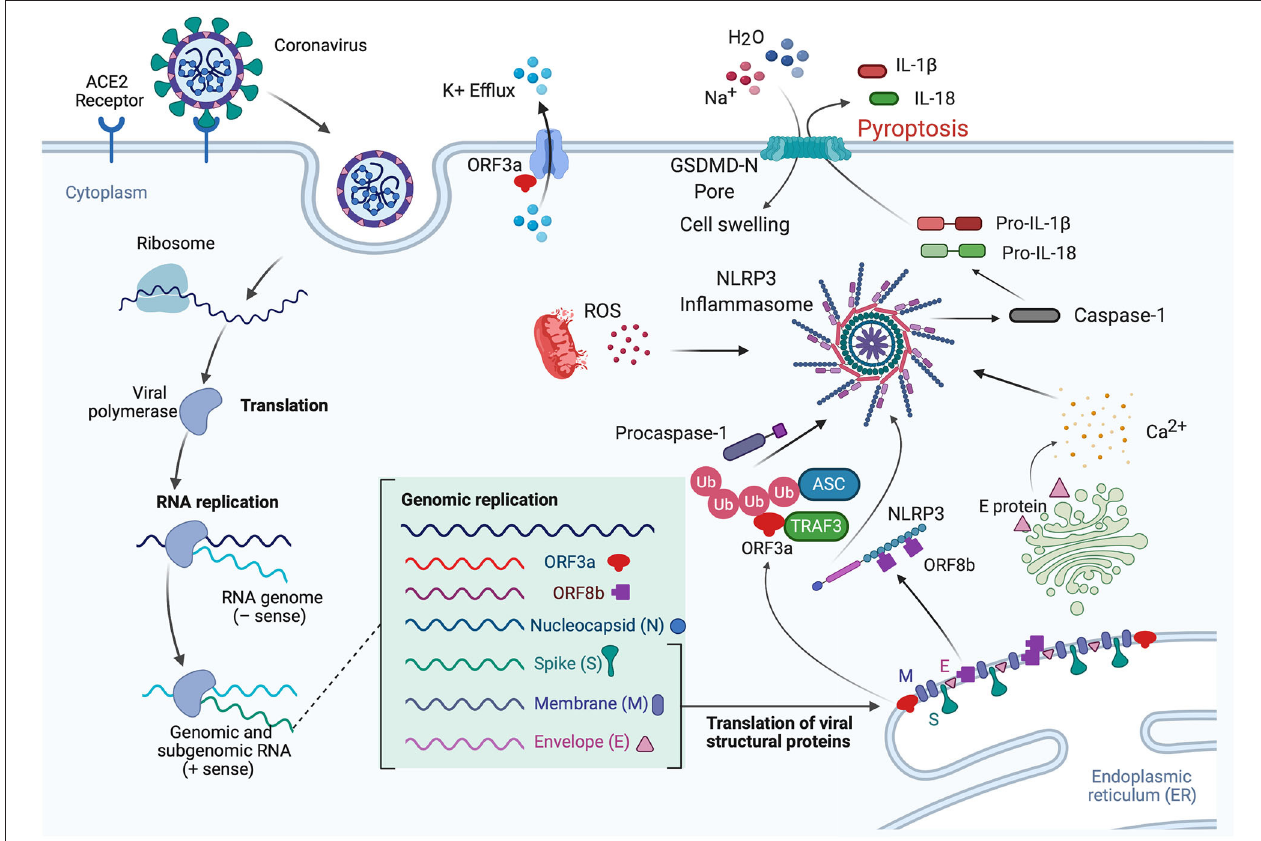
FIGURE 3 | Mechanisms of inflammasome activation in CoV infection. In the lungs when the S protein of SARS-CoV-2 binds to the ACE2 receptor, the virus is internalized by endocytosis, leading to translation and RNA replication of genomic and sub-genomic RNA including ORF3a, ORF8b, and the viral structural proteins (N, S, M, and E proteins). The E protein is involved in Ca 2 + release from the Golgi apparatus. This Ca 2 + has the potential to activate the inflammasome. In addition, ORF3a interacts with TRAF3 to ubiquitinate ASC, and ORF8b interacts with NLRP3, resulting in inflammasome activation and pyroptosis. IL-1 β is released through the GSDM-D-N pore during pyroptosis, while Na + and H 2 O molecules enter the cell, resulting in cell swelling, which then manifests as pulmonary edema. Furthermore, ORF3a also acts in the cell membrane as a K + channel, which causes an ionic imbalance also capable of promoting inflammasome activation, and mitochondrial dysfunction produces ROS that also contribute to inflammasome